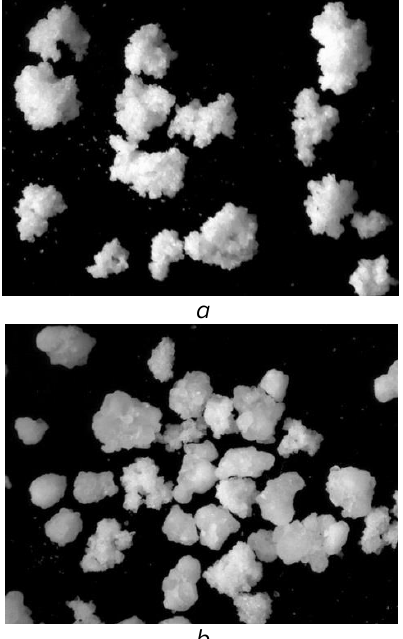
Fig. 1. Crystallographic analysis: a – granulate of lyso- zyme hydrochloride; b – a mixture of lysozyme hydro- chloride granulate with a composition HiG